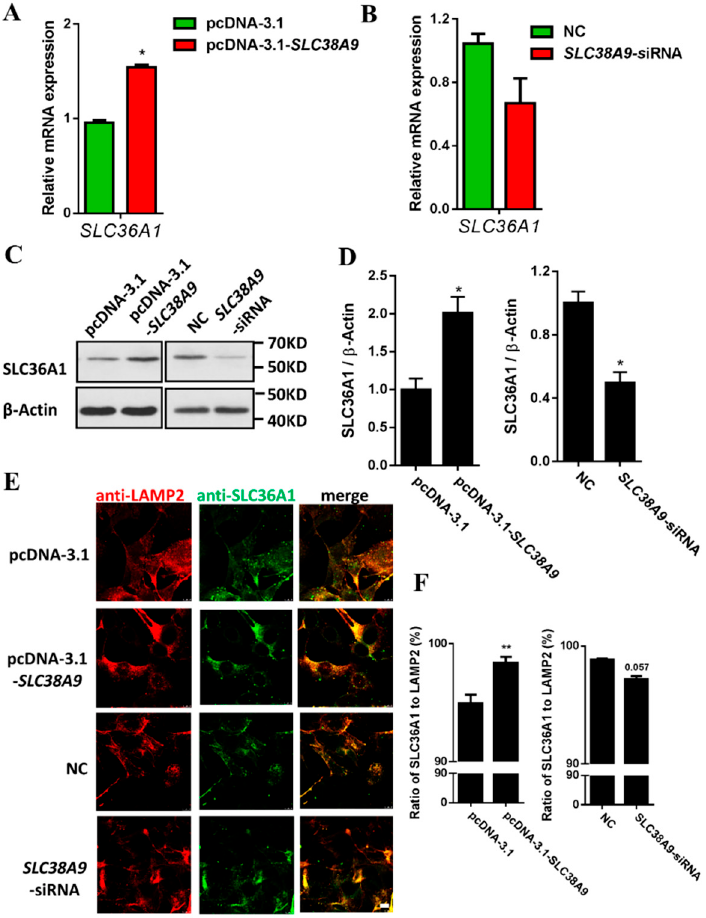
Figure 3. SLC38A9 increases SLC36A1 expression and promotes the translocation of SLC36A1 to LAMP2-positive lysosomal clusters. ( A ) C2C12 cells were transfected with pcDNA3.1-SLC38A9 construct to overexpress SLC38A9. The mRNA level of SLC36A1 was analyzed by qRT-PCR. ( B ) C2C12 cells were transfected with siRNA to knockdown SLC38A9. The mRNA level of SLC36A1 was analyzed by qRT-PCR. ( C ) Immunoblotting analysis of protein samples from ( A , B ) with anti- SLC36A1 or anti- β -Actin antibody. ( D ) Densitometric analysis of the immunodetection of SLC36A1 relative to β -Actin loading control. ( E ) C2C12 cells were transfected with pcDNA3.1-SLC38A9 construct or siRNA to overexpress or knockdown SLC38A9 and stained with anti-SLC36A1 or anti- LAMP2. Scale bar: 10 µ M. ( F ) Ratio of SLC36A1 to LAMP2 (%). To assess SLC36A1 translocation, the numbers of SLC36A1 and LAMP2-positive spots per cell were calculated using IPP6.0 and Image J software. Values are the mean ± SEM; n = 3; * p < 0.05; ** p <